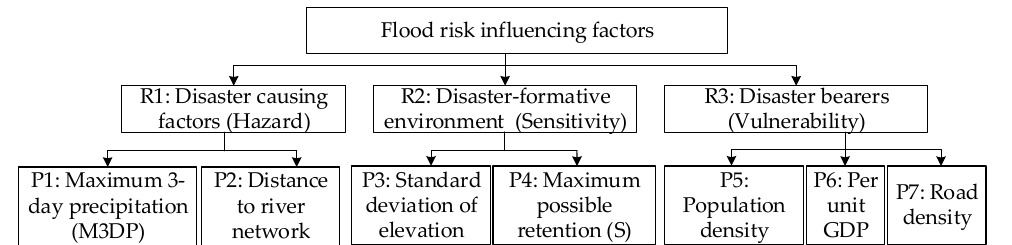
Figure 2. Wuhan flood disaster risk assessment index system.